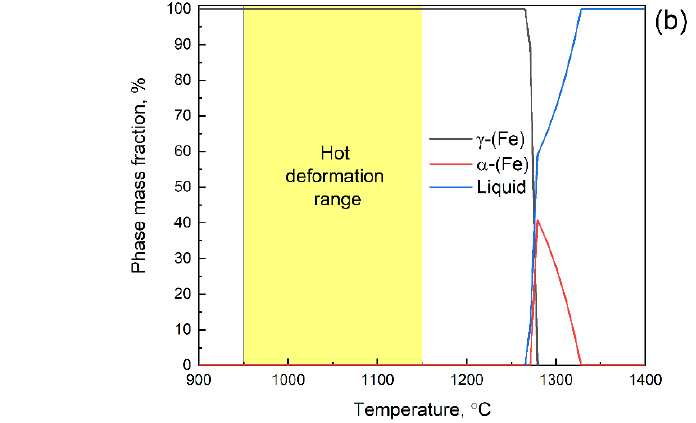
Figure 3. The calculated mass fraction of solid phases (Scheil model) ( a ) and high-temperature phase composition ( b ) of the Fe-35Mn-10Al-1C steel.